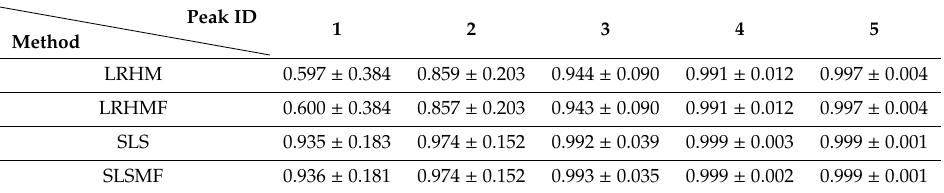
Table 4. Statistics of peaks correlations and standard deviations.